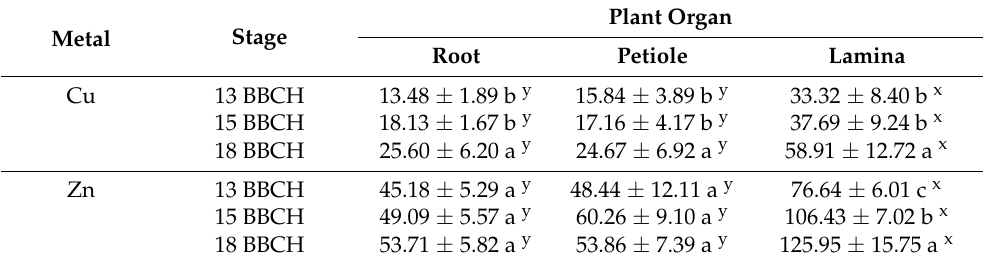
Table 4. Cu and Zn concentrations in different plant organs and development stages of S. perfoliatum . Plant Organ Metal Stage Root